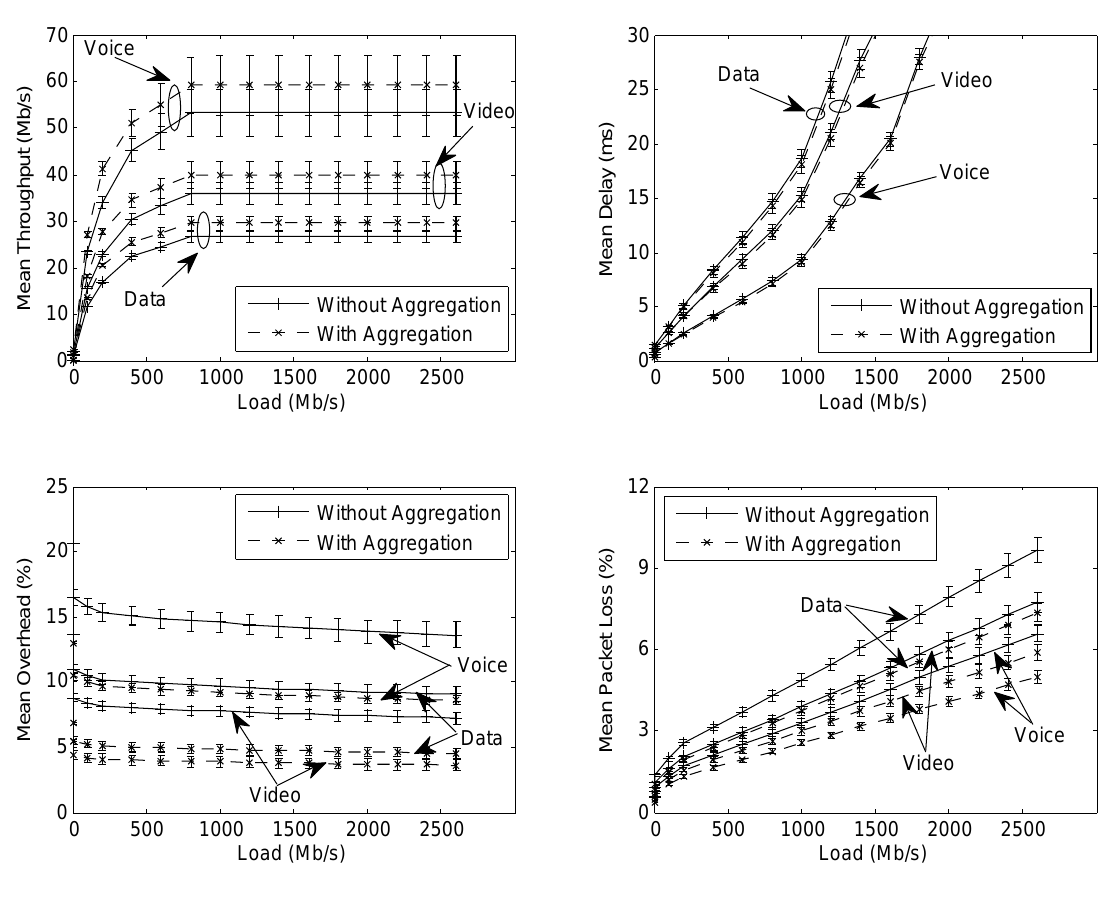
Figure 12. Impact of advanced aggregation techniques on integrated EPON-WLAN network performance for a 54 Mb/s WMN under voice, video, and data traffic.